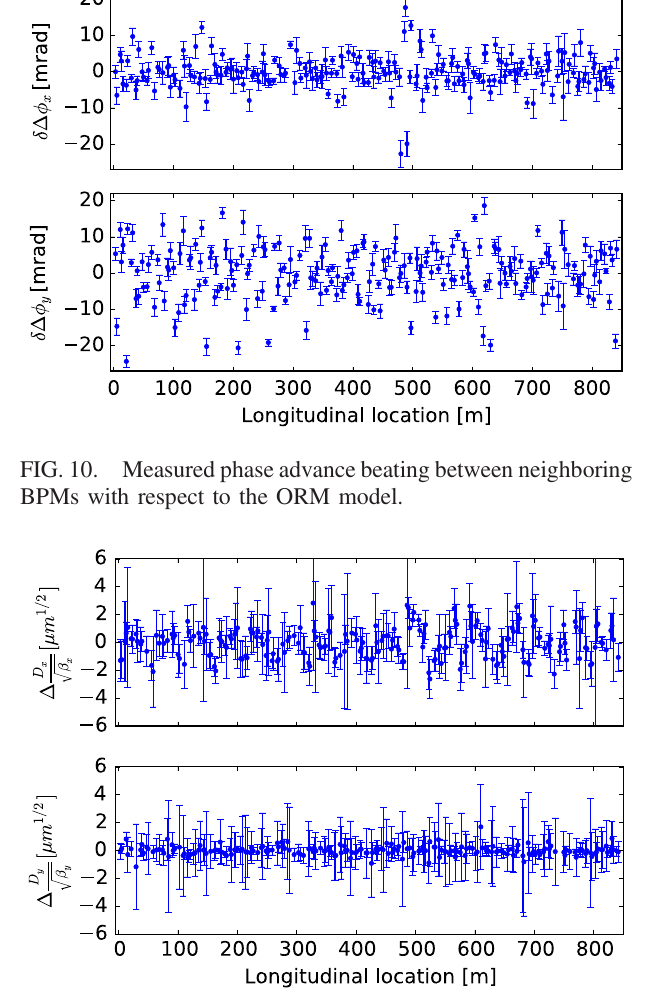
FIG. 11. Difference between measured normalized dispersion obtained from TbT data and from